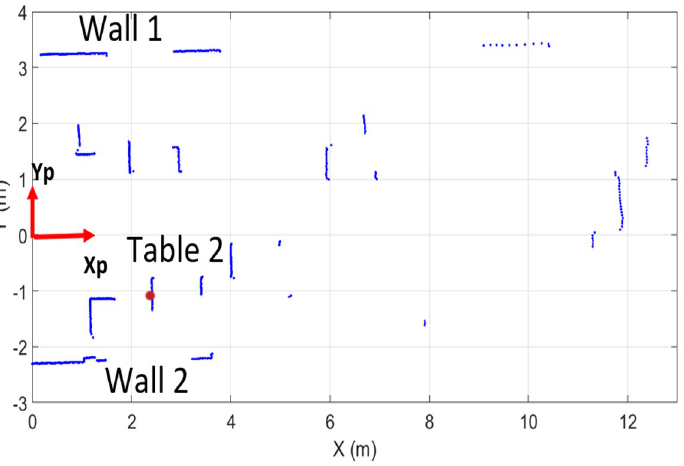
Fig 7. Laser scans of indoor environment of